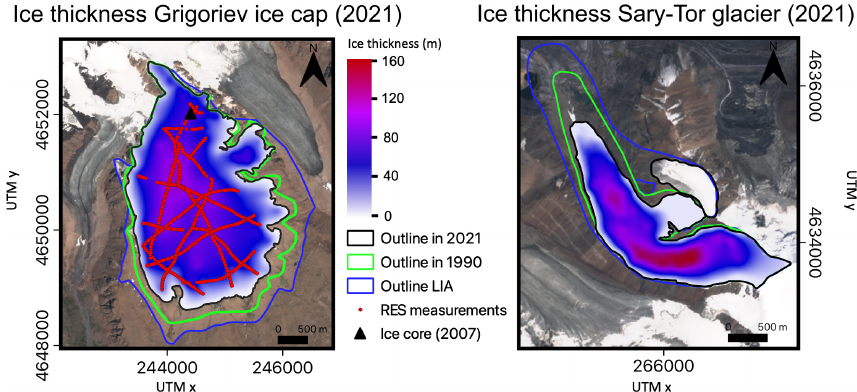
Figure 2. Ice thickness distribution of the Grigoriev ice cap and the Sary-Tor glacier in 2021. The locations of the ice thickness measurements of 2021 on the Grigoriev ice cap are added in red. The background is a Sentinel-2 image from 26 July 2021. The location of the ice core made in 2007 (Takeuchi et al., 2014) is added with a black triangle.